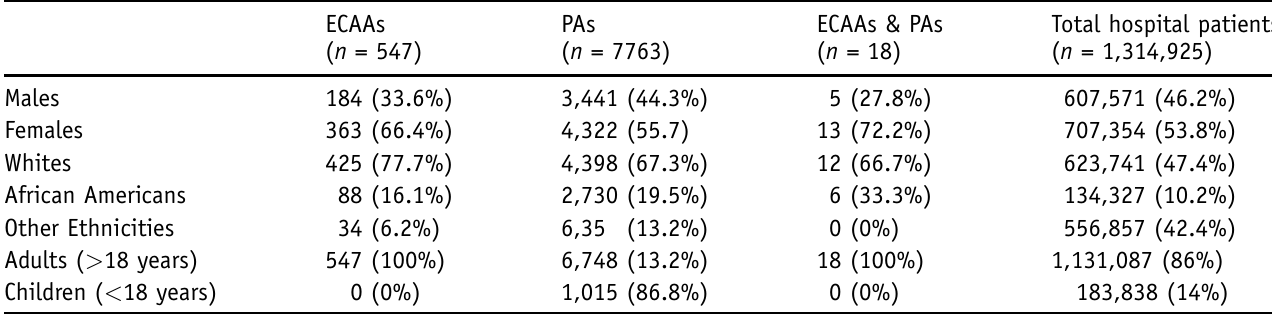
Table I. Demographics of the patient population studied.